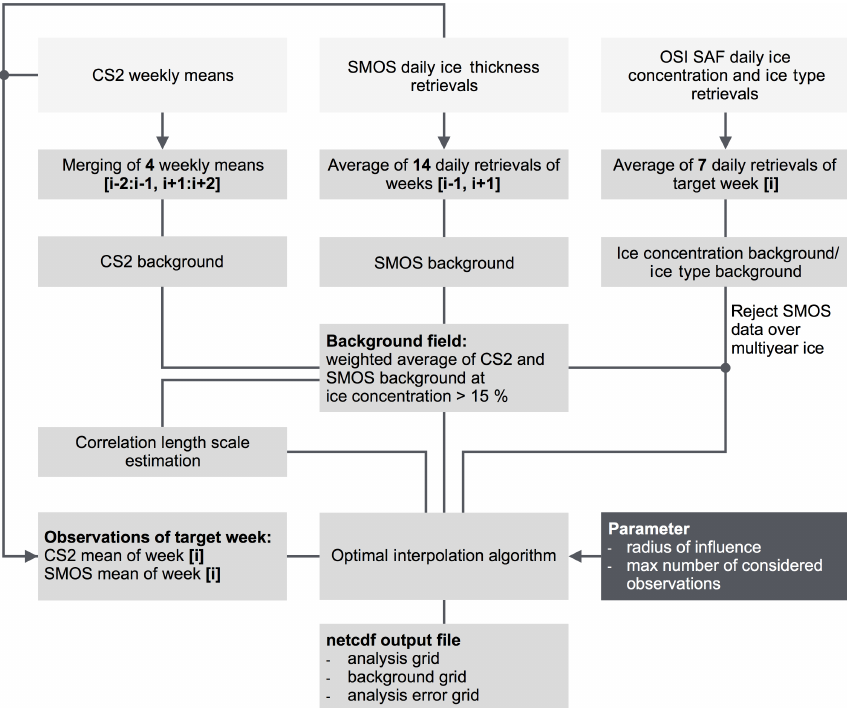
Figure 5. Optimal interpolation processing scheme. Week [i] represents the target week. The cycle is repeated for each week.